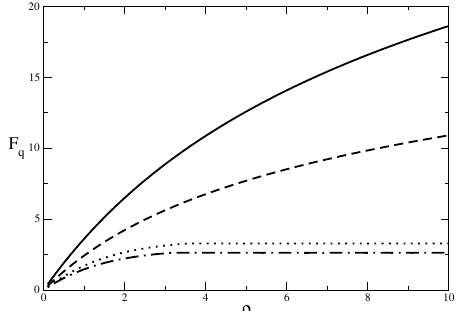
Fig. 2. Exit time expectations for q = 0 (which means extinction of the population) calculated on the basis of Eq.(36). ρ on the horizontal axis is equal to ρ from Eq.(36). For all curves b = 2 . Solid line: α 0 = 0 . 01 ; α 1 = − 0 . 1 ; α 2 = α 3 = 0 . Dashed line: α 0 = 0 . 01 ; α 1 = − 0 . 2 ; α 2 = α 3 = 0 . Dot-dashed line: α 0 = 0 . 1 ; α 1 = − 0 . 2 ; α 2 = 0 ; α 3 = − 0 . 1 ; Dotted line: α 1 = 0 . 01 ; α 1 = 0 . 2 ; α 3 = 0 . 1 ; α 3 = − 0 . 1 . As we see the negative values of α 1 , 3 make extinction be expected sooner whereas the positive values of the other two parameters can delay the